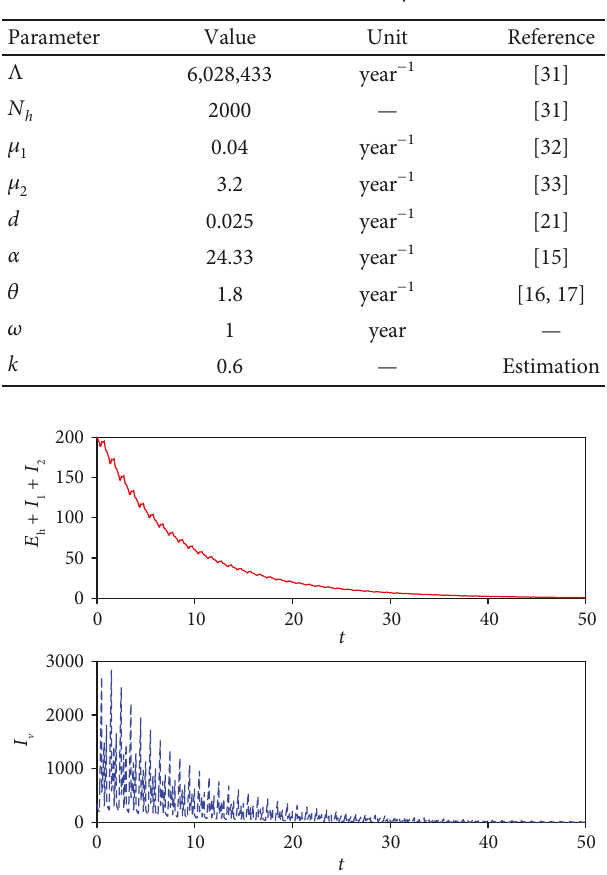
Figure 2: Time series plots of the total of infected trees and infected psyllids. The disease dies out with R